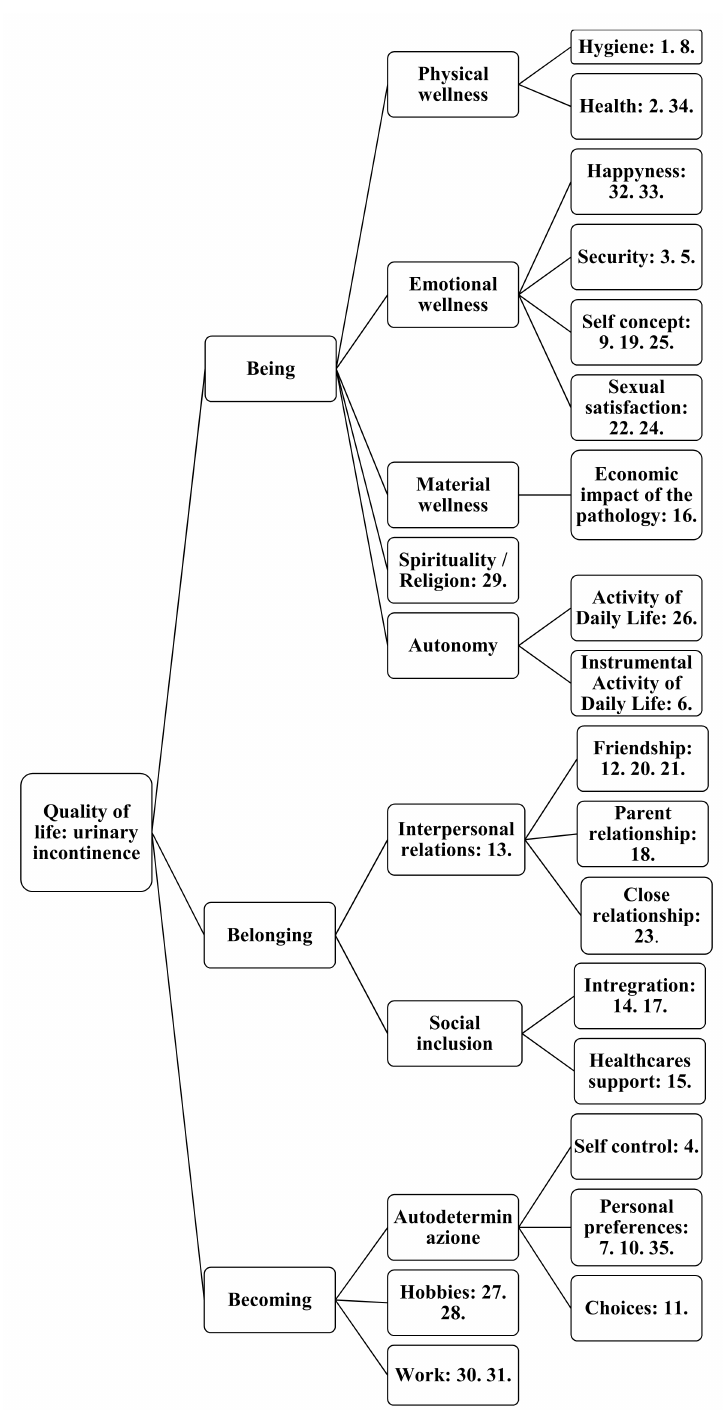
Figure 1. This figure shows the quality of life domains analysed using the